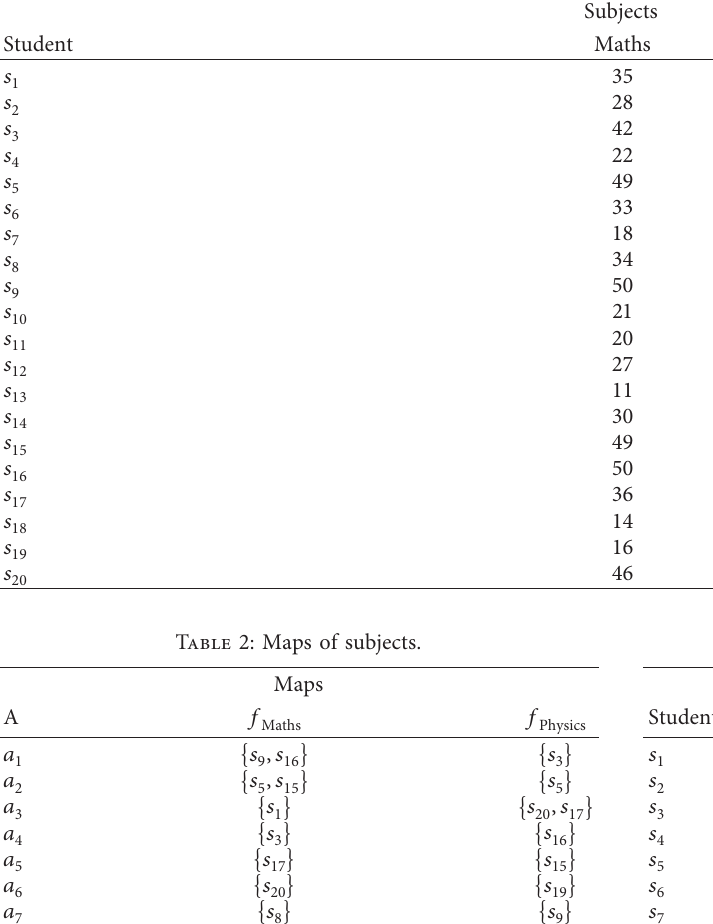
Table 1: Subjects’ marks of twenty students.